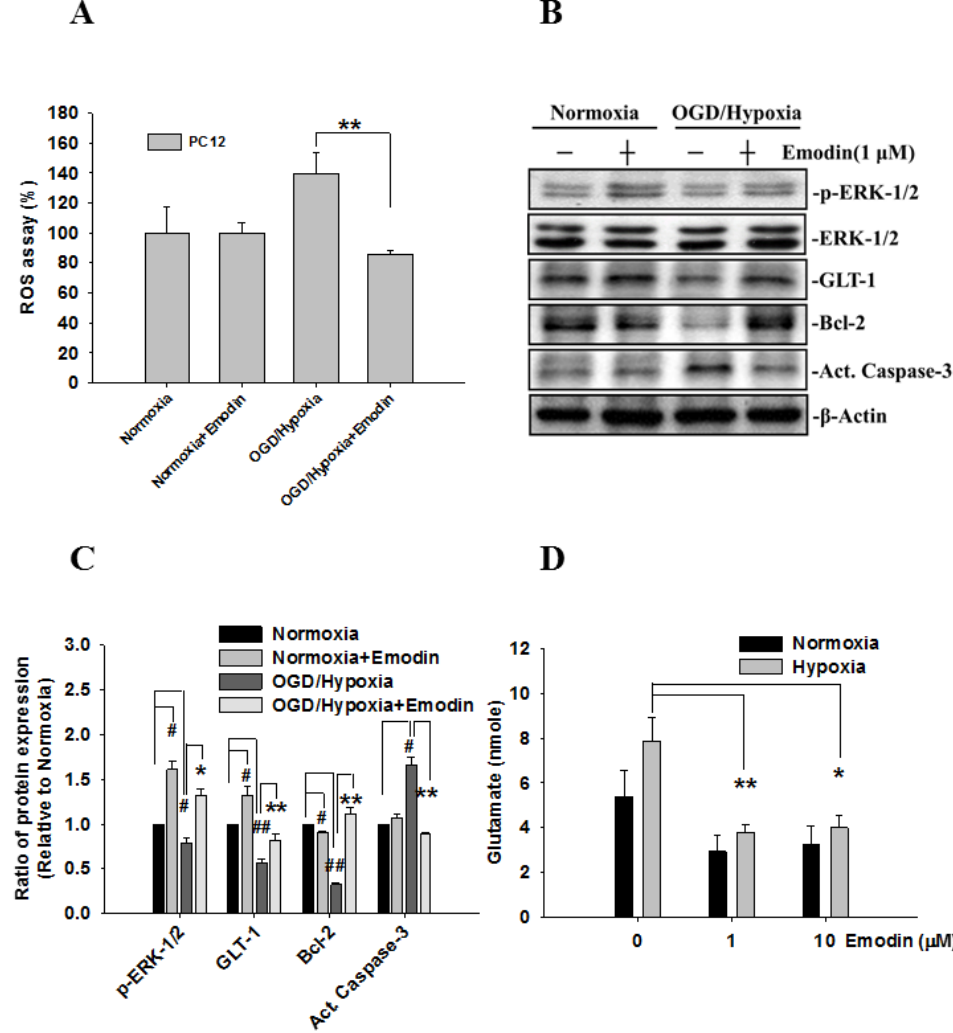
Figure 2. The e ff ects of Emodin treatment of PC12 cells after OGD / Hypoxia on reactive oxygen species (ROS) production, glutamate release, and apoptosis are regulated through the extracellular signal-regulated kinase (ERK)-1 / 2 signaling pathway. ( A ) The protective e ff ects of Emodin on ROS under OGD-hypoxia. ( B ) Phosphorylation levels of ERK-1 / 2 and the expression of GLT-1, Bcl-2, and activated caspase-3 (Act. Caspase-3) were examined by western blotting. ( C ) Bar graph showing semi-quantified densitometry. The ratio of p-ERK-1 / 2 was normalized to the levels of ERK-1 / 2 and β -Actin. ( D ) Glutamate was collected from cell culture medium after normoxia or OGD-hypoxia for 24 h and was detected with a colorimetric assay. The # and * indicate separate comparisons with normoxia and OGD-hypoxia conditions. * p , # p < 0.05 and ** p , ## p < 0.01 using Student’s t -test. Rats pretreated with Emodin exhibited smaller infarct sizes (white area) after MCAO, and the total volume of the infarcts was significantly di ff erent (Figure 3A,B). The di ff erence in volume was at decrease in both Terminal Deoxynucleotidyl Transferase dUTP Nick End Labeling (TUNEL) staining